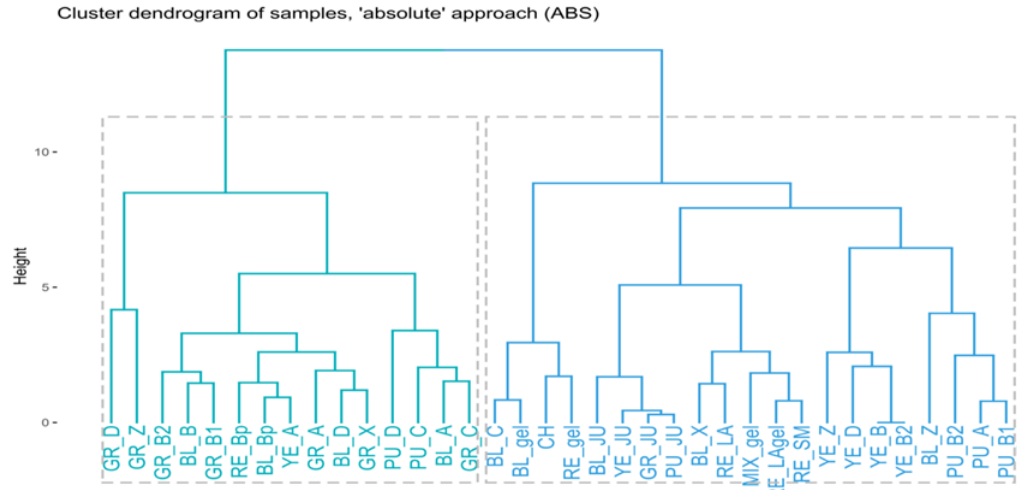
Figure 3. Cluster dendrogram prepared on the basis of the ABS dataset.